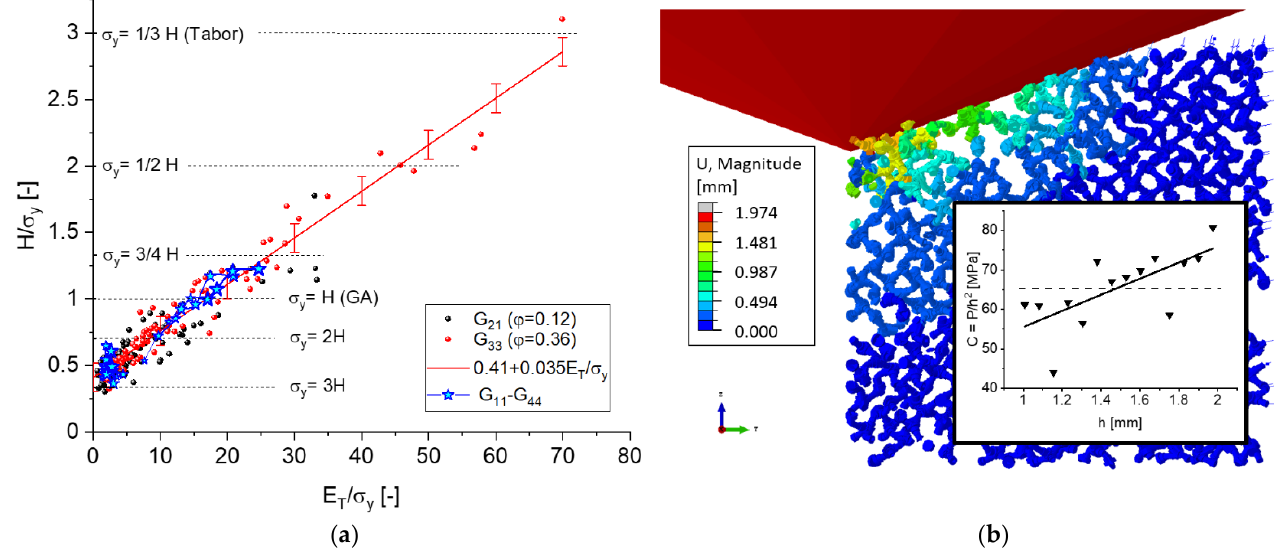
Figure 15. ( a ) Correlation of H / σ y with E T / σ y for ligament shapes G 21 ( ϕ 0 = 0.12 ) and G 33 ( ϕ 0 = 0.36 ) . ( b ) Deformation shown for a slice of one unit cell of the indented RVE with A = 0.18 and ζ = 0.26, for which the stress–strain curve is shown in Figure 2b.